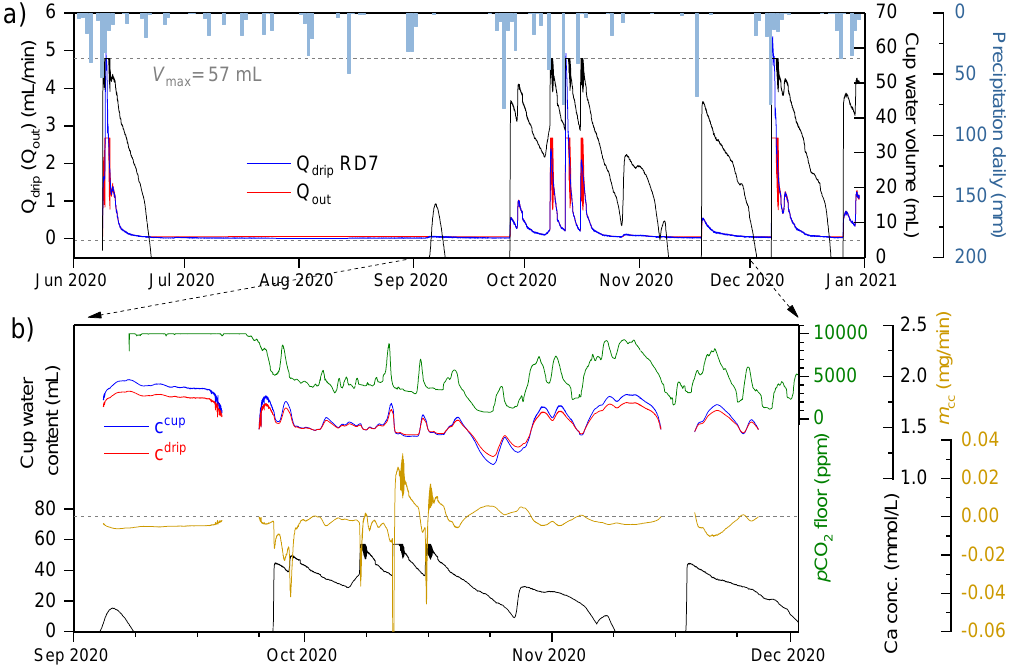
Figure 15. ( a ) Results of the calculation of the dynamics of the cup water volume (black curve) from the dripwater discharge Q drip (blue curve) and the drainage rate Q out (red curve) compared to the daily precipitation (blue bars). The maximum volume V max was calculated to be 57 mL, while the minimum volume could drop to zero (dry cup). ( b ) Comparison between p CO 2 at the floor level, the Ca concentration in the cup and the drip, the change in calcite mass (precipitation—positive; dissolution—negative) and the cup water content. The largest negative spikes in m cc occur when the p CO 2 is high, just before the cup is full and when Q out is highest.